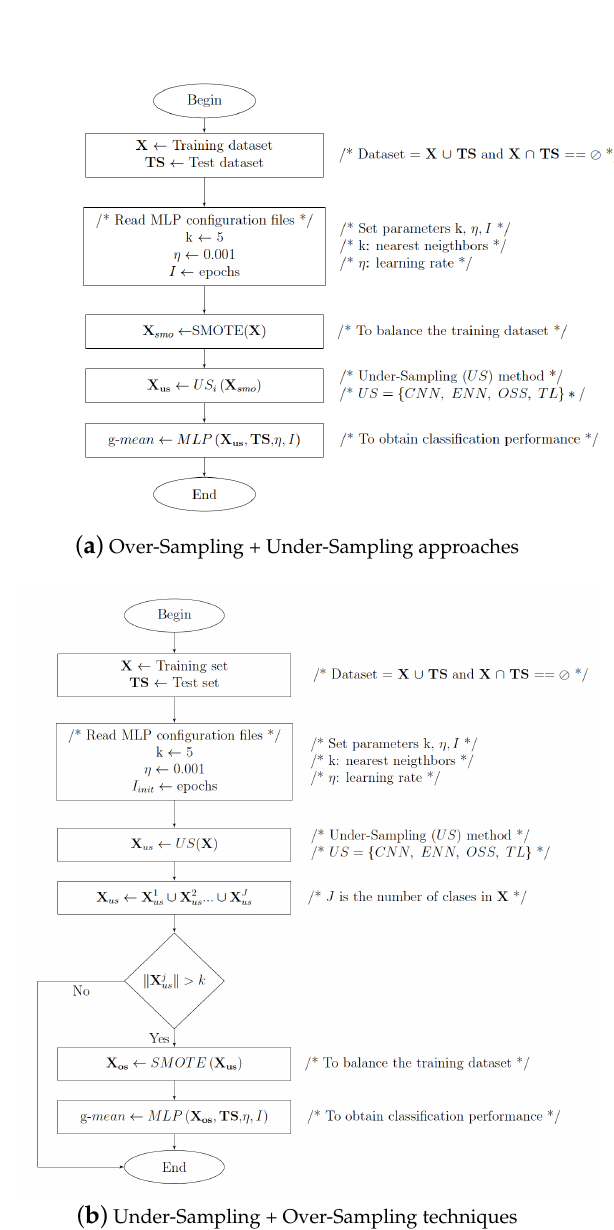
Figure 1. Flowchart of hybrid sampling